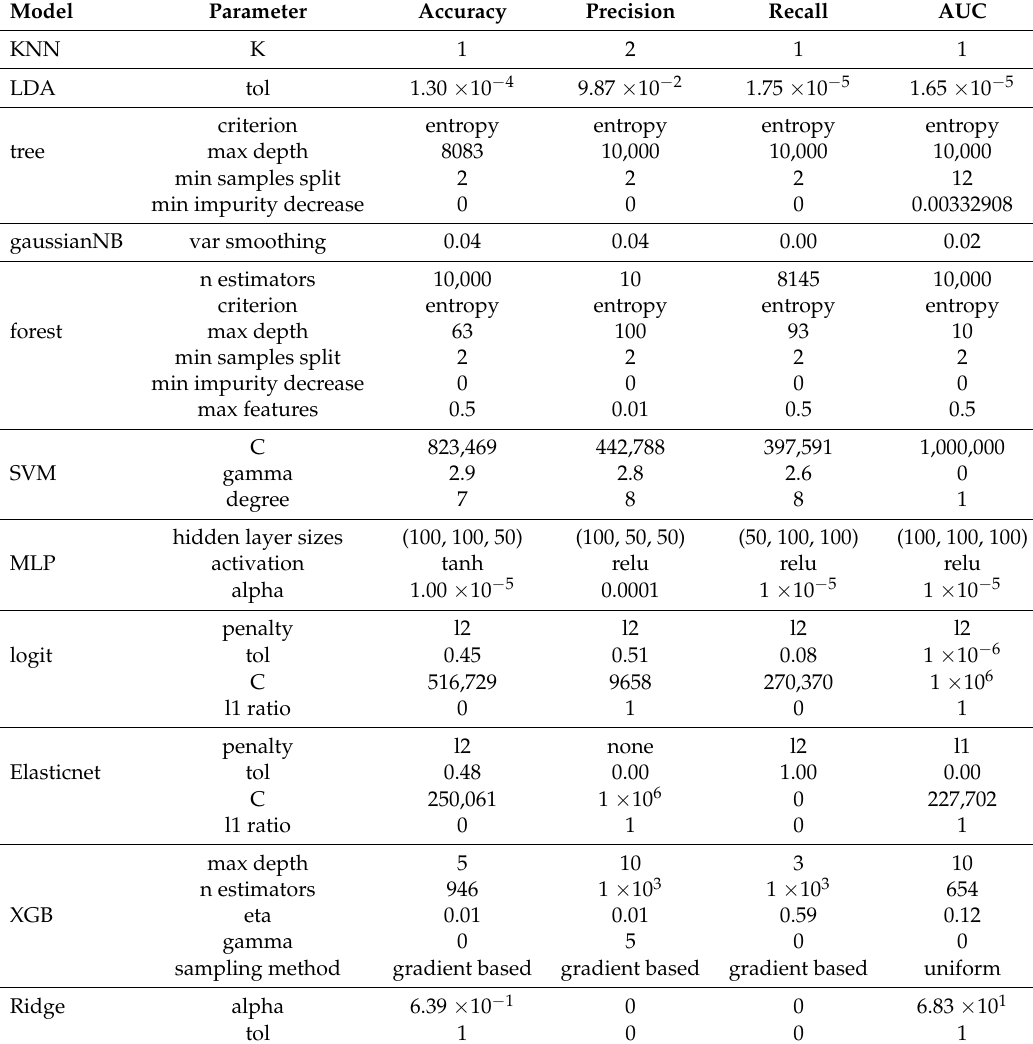
Table A1. Optimal hyper-parameters for 1-week injury